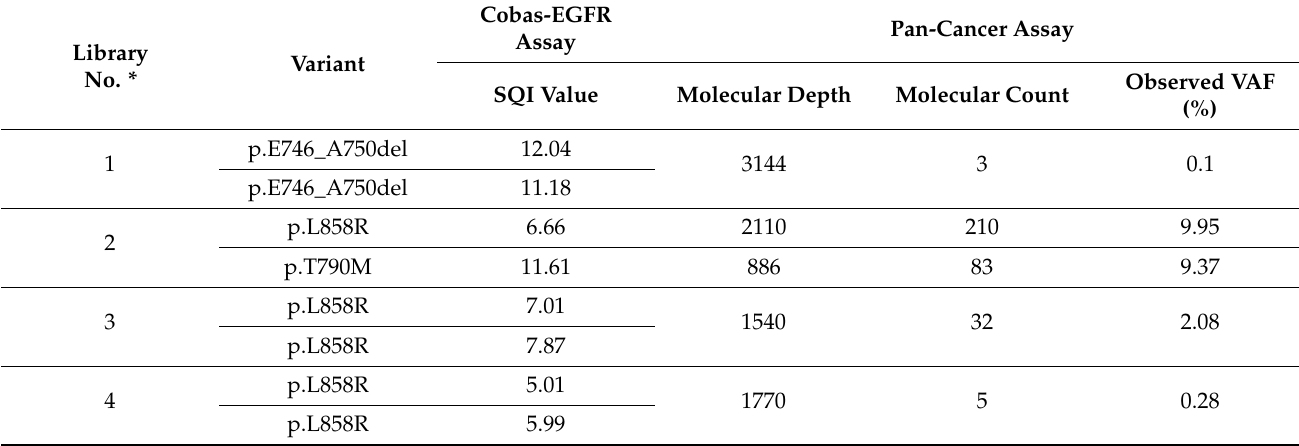
Table 5. Comparison between Pan-Cancer Cell-Free Assay and Cobas-EGFR assay from samples with EGFR mutation.